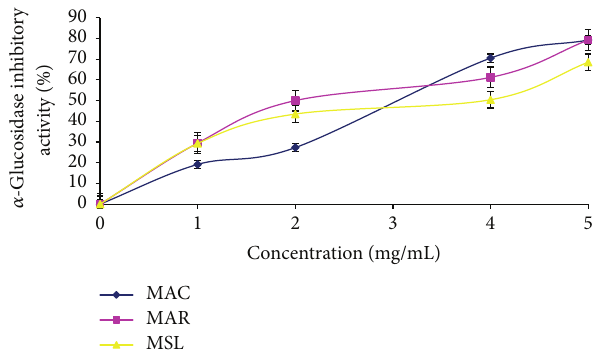
Figure 3: 𝛼 -Glucosidase inhibitory activity of Musa sapientum (Latundan banana) (MSL), Musa acuminata (Cavendish banana) (MAC), and Musa acuminate (Red Dacca)